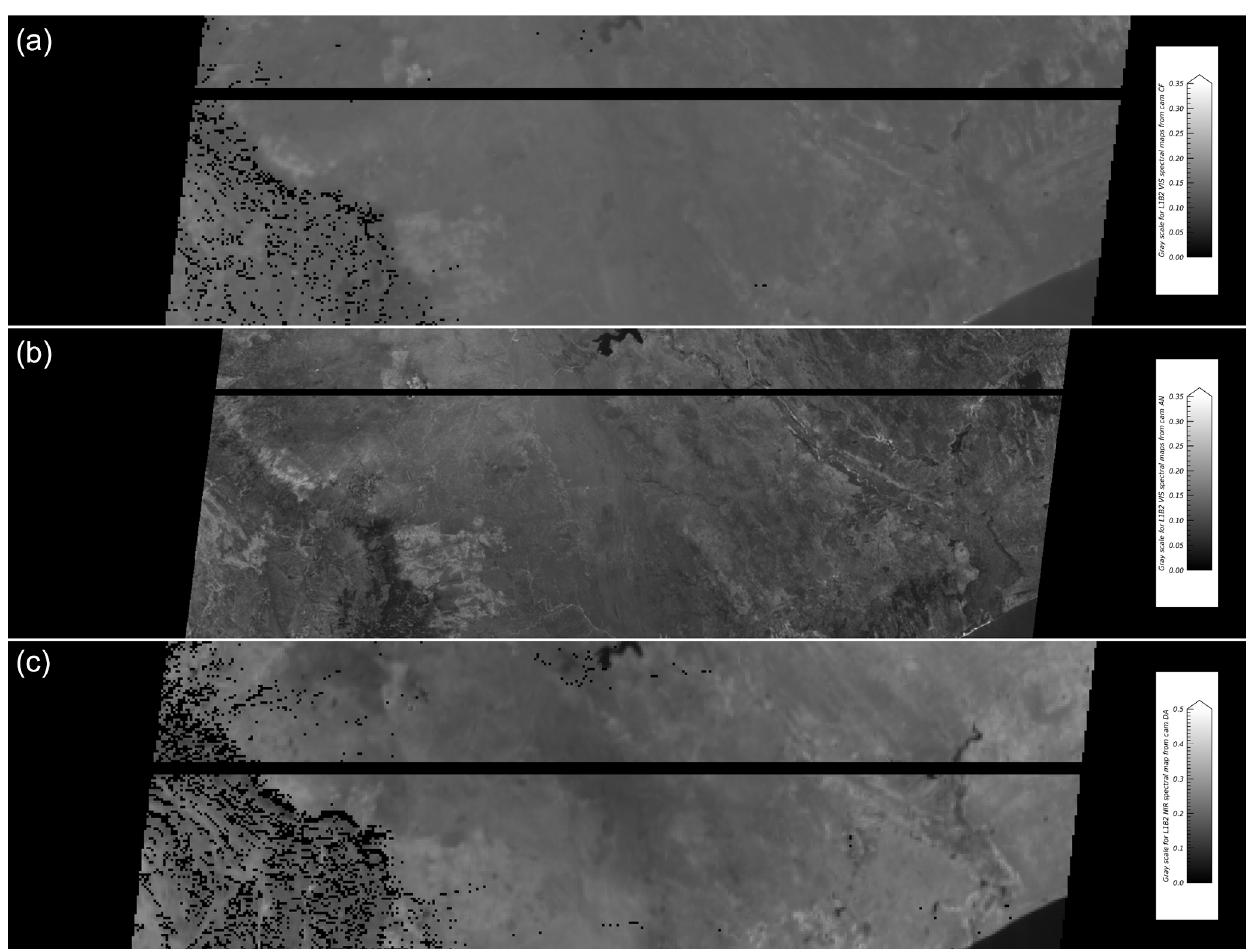
Figure 17. Maps of the MISR L1B2 data channels for the CF/green, AN/red and DA/NIR data channels of P168, O068050 and B110, where missing data have been inserted artificially for the purpose of testing the algorithm described in this paper. The linear dimensions are the same as in Fig. 1, and gray scale stretching is the same as before: it assigns black to a null reflectance and white to reflectances of 0.35 or more in the blue, green and red spectral bands and 0.50 in the near-infrared spectral band.